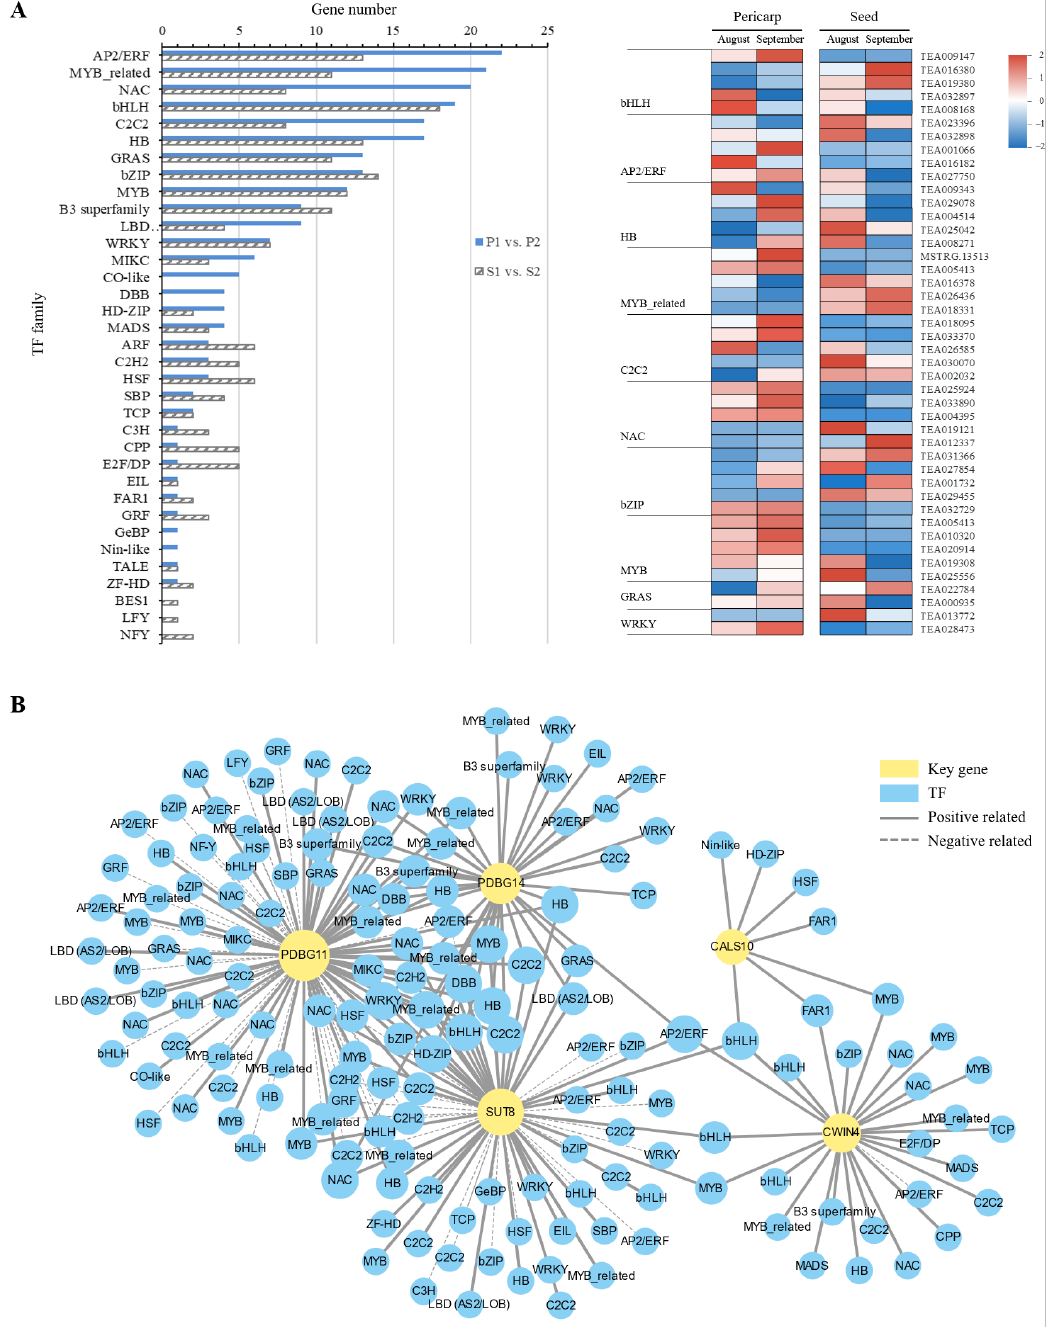
Figure 5. Differentially expressed transcription factors related to phloem unloading and their co- expression networks with candidate structural genes ( A ) Distribution of differentially expressed transcription factors (TFs) for the different unloading stages in pericarp (P1 vs. P2) or seeds (S1 vs. S2). Expression profiles of some TFs differentially expressed in fruit pericarp and seeds are shown in heatmap; ( B ) Co-expression networks between candidate structural genes in the phloem unloading and differentially expressed transcription factors (TFs). The width of the edge between each TF node and structural gene node represents the correlation coefficient.